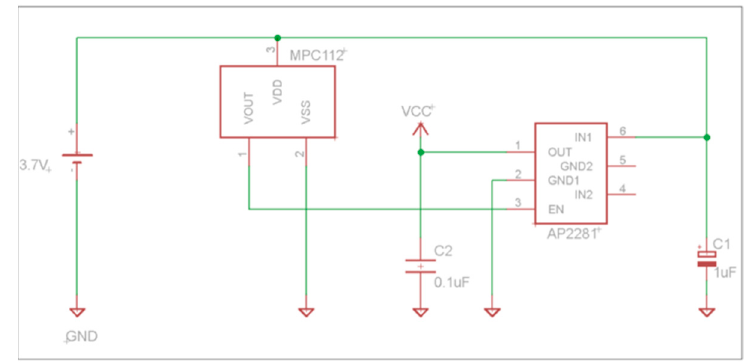
Figure 4. Schematic of protection discharge circuit.